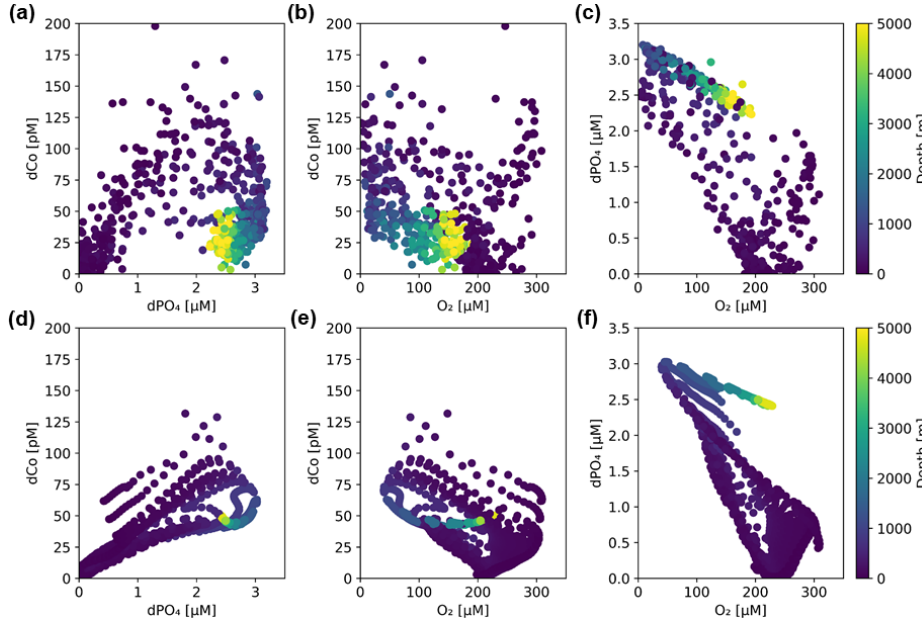
Figure 15. Nutrient relationships between dCo, dPO 4 and O 2 in (a) – (c) binned observed values and (d) – (f) model output values. Observed values have been binned and averaged by 1 ◦ latitude and 31 depth divisions to ensure comparability between the model and sample values. Note that O 2 values are reported here in units of